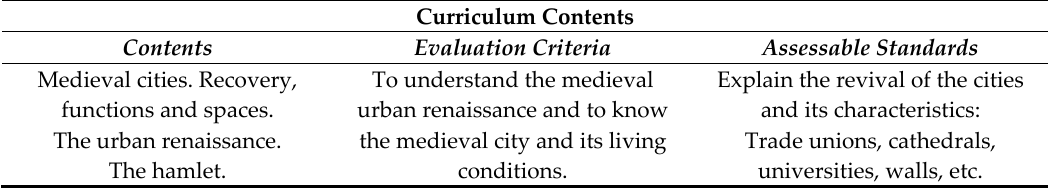
Table 1. Curriculum contents developed in the educational experience. Source: decree